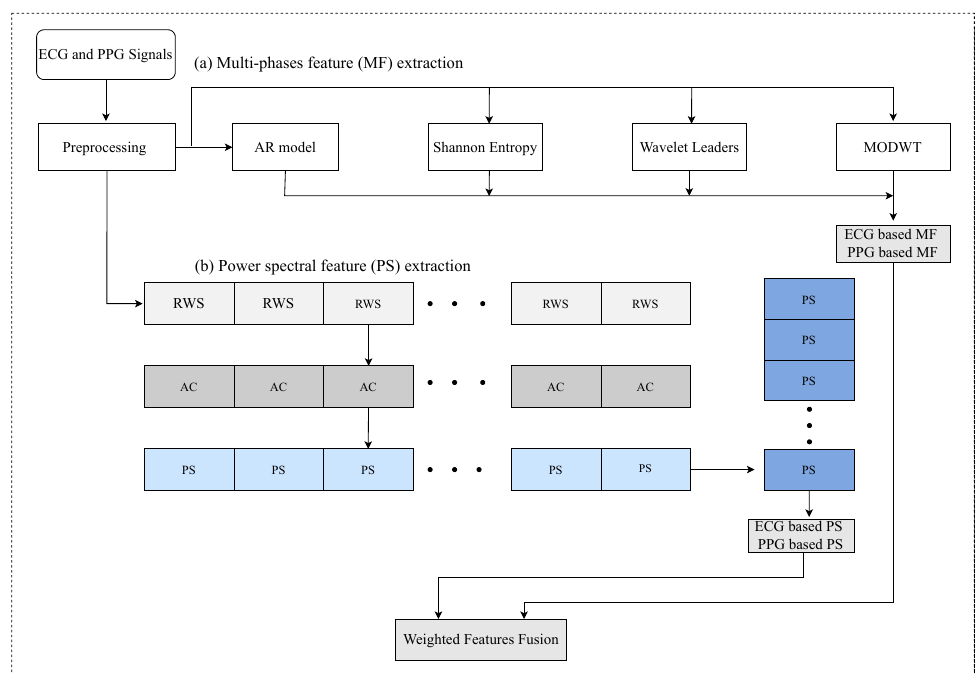
Figure 3. Hybrid feature extraction and weighted features fusion process, where ( a ) denotes the detailed process of parallel feature extraction using multi-phases (MF) model and ( b ) denotes power spectral (PS) feature extraction, where RWS denotes a segmented resample wave signal, AC is an autocorrelation for each record or